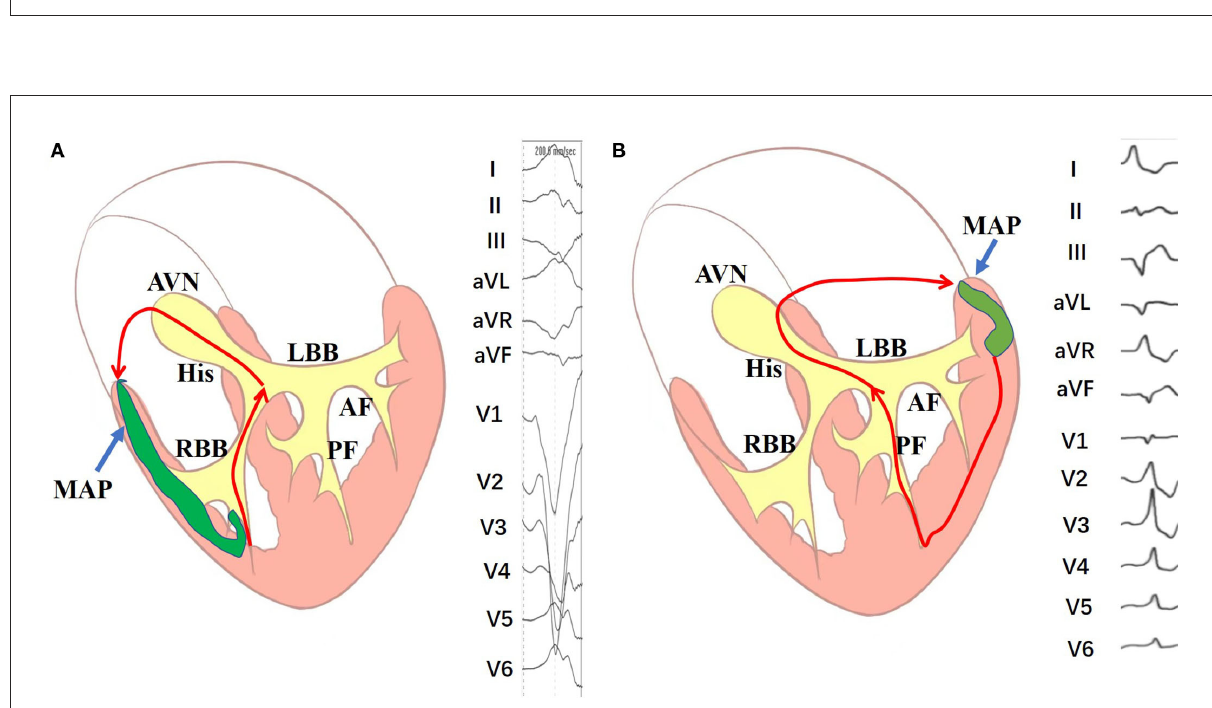
FIGURE5 Schematic diagram of the mechanism of the long-length and short-length Mahaim-mediated tachycardias. (A) The mechanism of right-sided long-length Mahaim-mediated tachycardias. (B) The mechanism of left-sided short-length Mahaim-mediated tachycardias. AF, anterior fascicle; AVN, atrioventricular node; LBB, left bundle branch; MAP, Mahaim accessory pathway; PF, posterior fascicle; RBB, right bundle